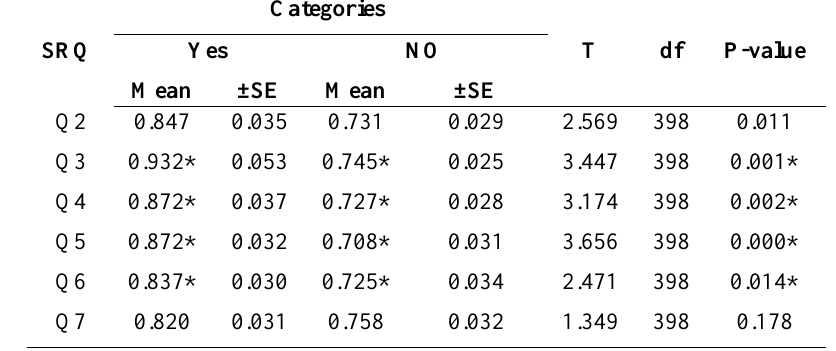
SRQ= self-reported questionnaire of halitosis No.= number Table (4) ׃ Descriptive and statistical test of gingival index among questionnaire